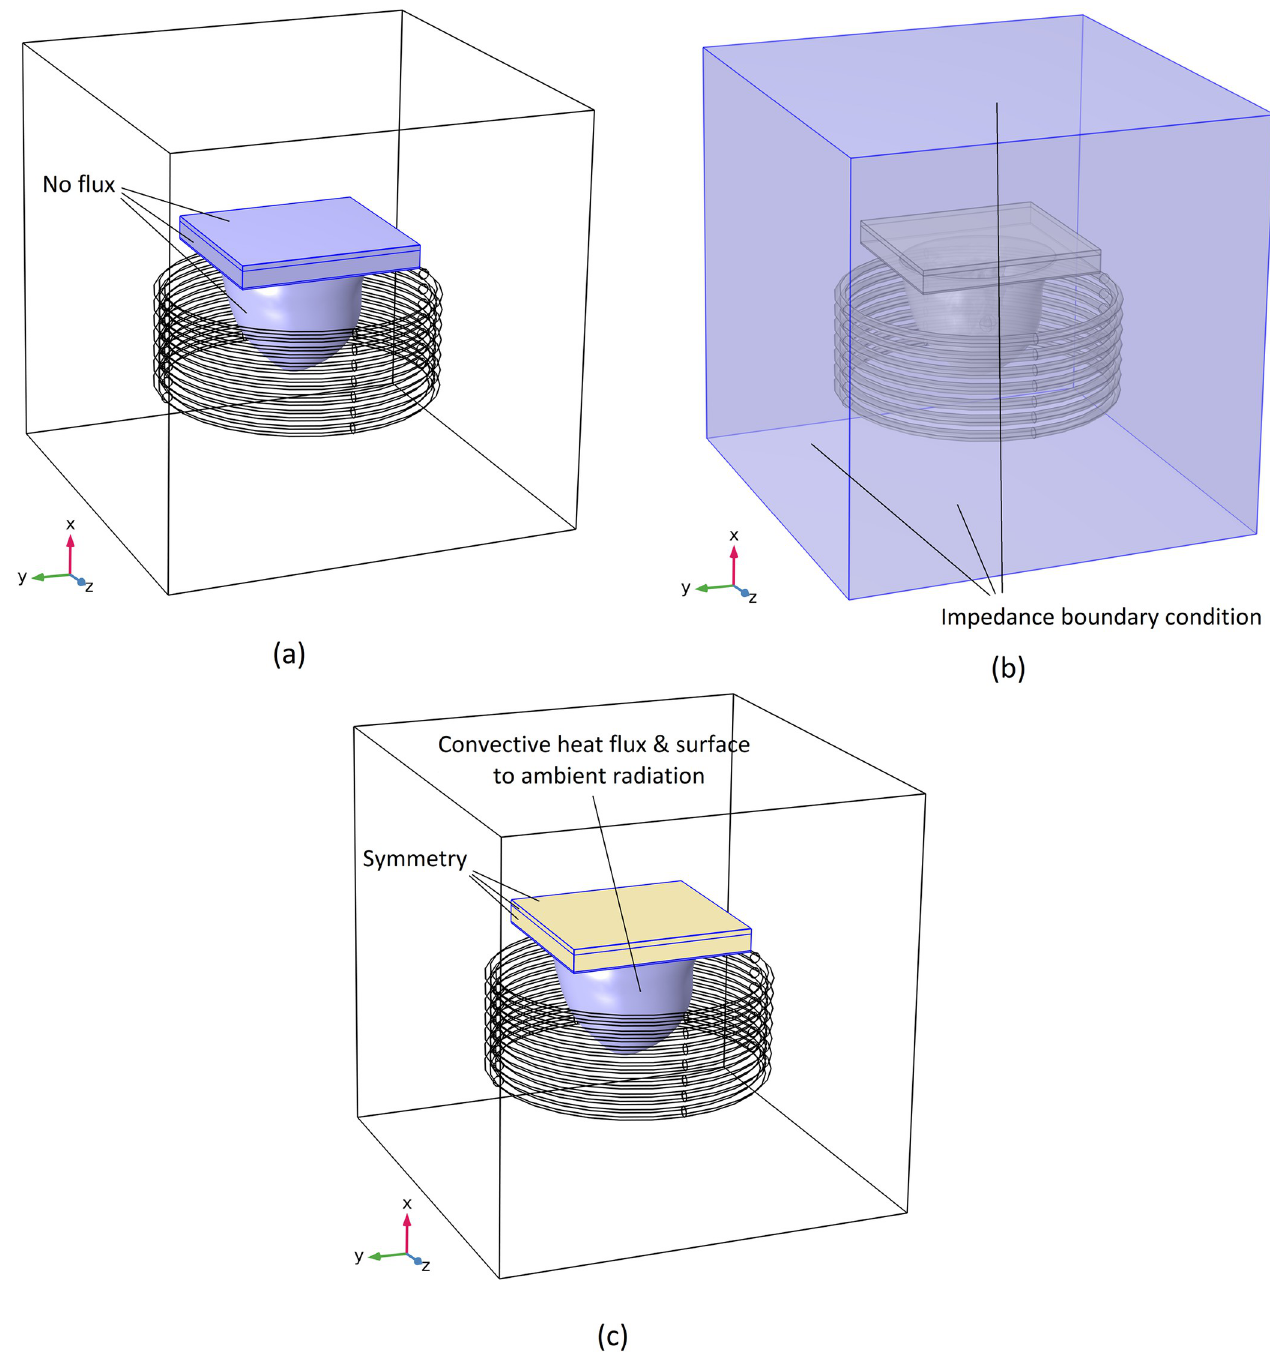
Fig 5. Boundary conditions considered in different physics, (a) transport of diluted species, (b) magnetic fields, and (c) bioheat transfer.